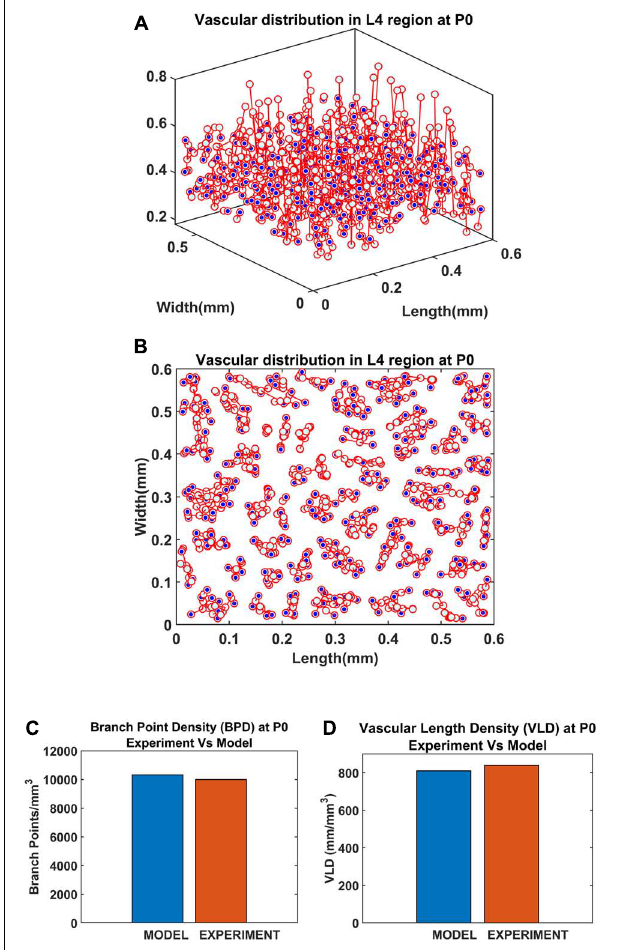
FIGURE 12 | Vascular distribution at the L4 region at the time of birth (P0). The blue dots denote the vascular terminal leaf nodes. (A) The 3D view of the L4 region and (B) the top view of the L4 region. (C) Comparison of branch point density (BPD) in control and lesioned animal. (D) Comparison of vessel volume length density (VLD) in control and lesioned